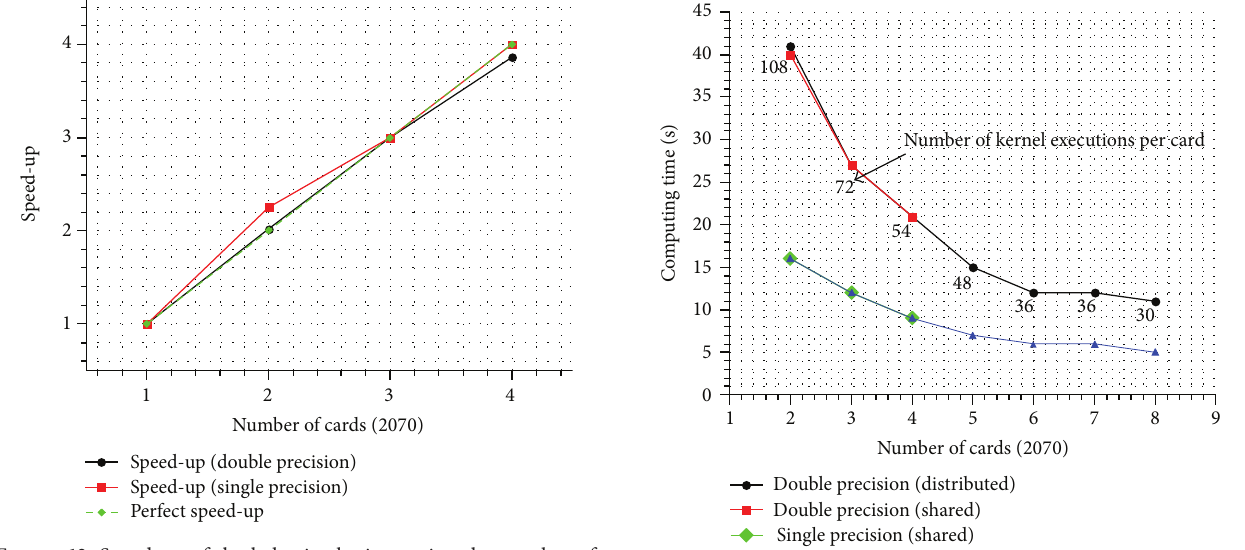
Figure 12: Speed-up of the behavior by increasing the number of processing cards in double and single precision. The number of blocks is 14 and the number of threads per block is 512 in every card, the optimal setup found for one single card.